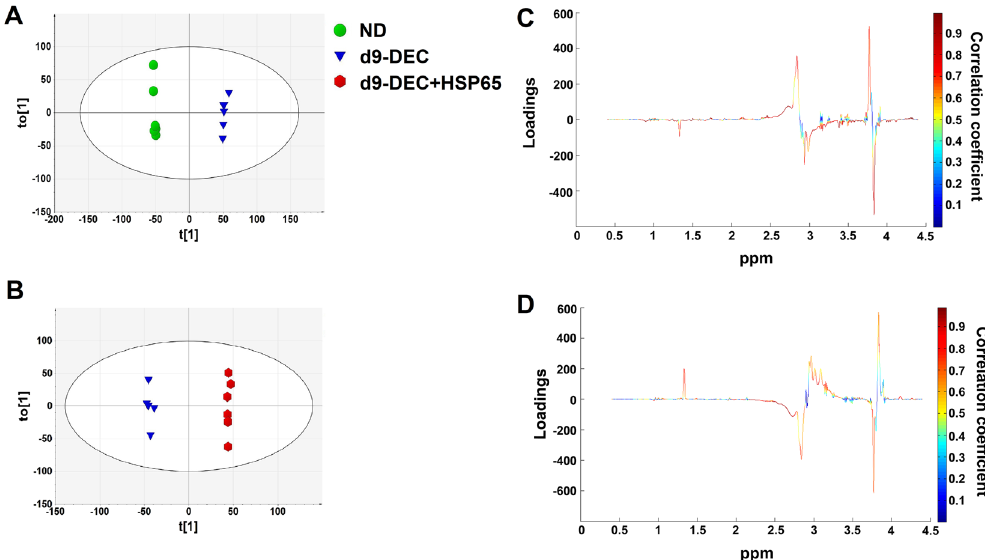
Figure 4. OPLS-DA analysis of culture media metabolic profiles of ND, d9-DEC and d9-DEC + HSP65. OPLS-DA of ND vs DEC [R2X = 73.1%, R2Y = 0.998, Q2 = 0.981 and CV-ANOVA score p = 0.00267644] ( A ) and DEC vs DEC + HSP65 [R2X = 73.6%, R2Y = 0.998, Q2 = 0.958 and CV-ANOVA score p = 4.33 × 10 − 5 ] ( B ). Coefficient color coded loading plots corresponding to OPLS-DA model of ND vs DEC ( C ) and DEC vs DEC + HSP65 ( D ) are